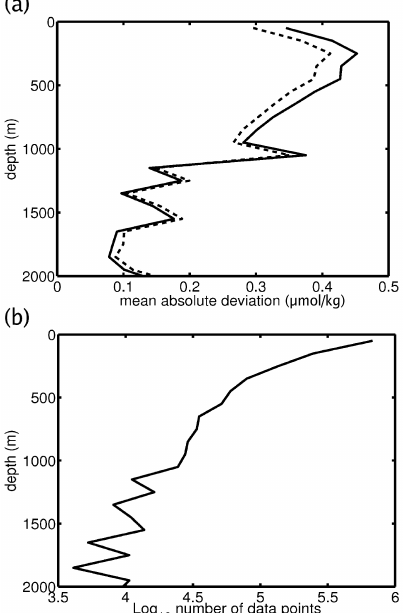
Fig. 4. Mean absolute deviation of WOD05 phosphate down to 2000m. Solid line: deviation against depth; dashed line: deviation against density. Plot (b) shows the number of data points available to estimate (a)